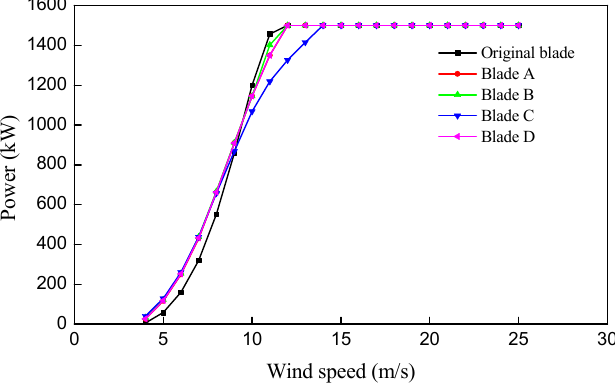
Figure 18. Comparison of powers under different wind speed.